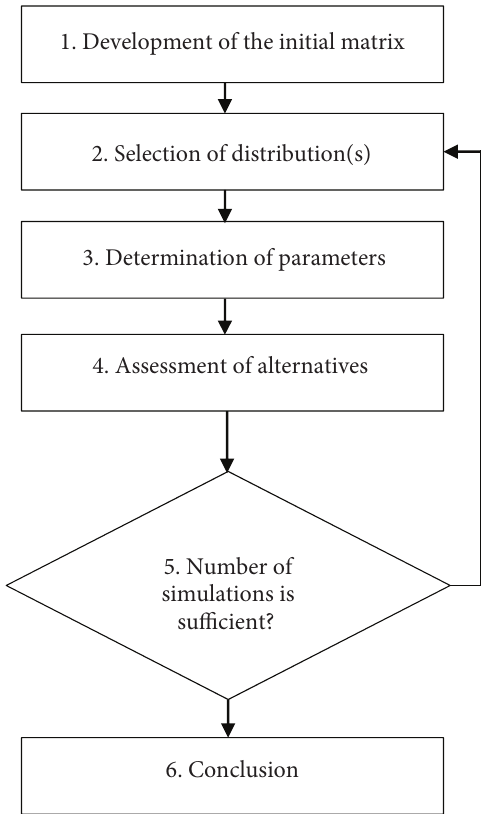
Figure 2. Algorithm for sensitivity